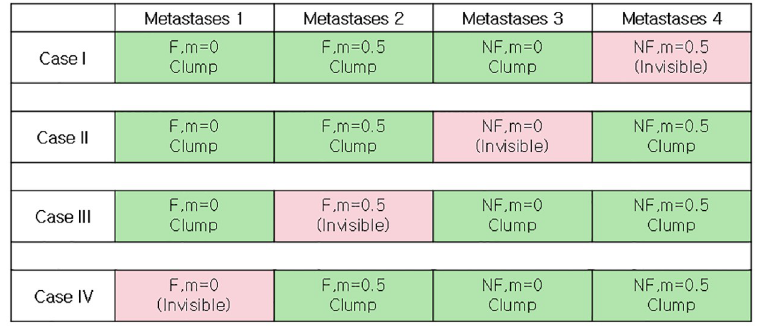
Fig 11. Combinations of the four metastasis scenarios. The green and red colors correspond to detected and undetected metastases, respectively. F and NF correspond to the existence and absence of fibroblasts,